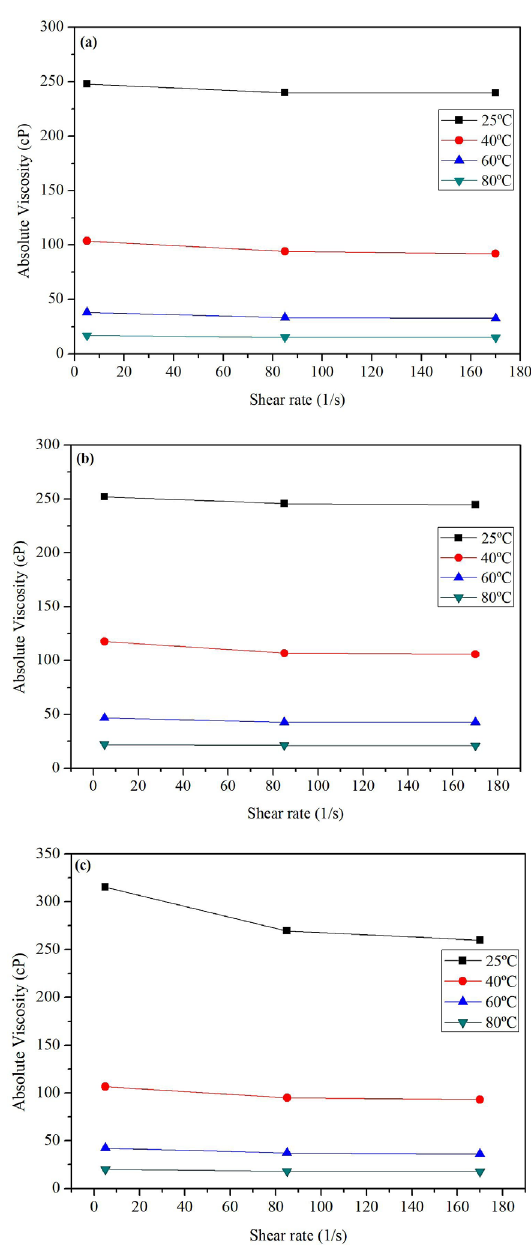
Figure 4. Viscosity versus shear rate at different temperatures for surfactant: (a) NP4EO, (b) NP6EO and (c)